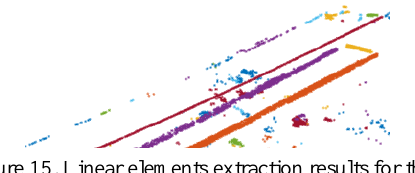
Figure 15. Linear elements extraction results for the partial enlarged part of Data 4 (coloured by